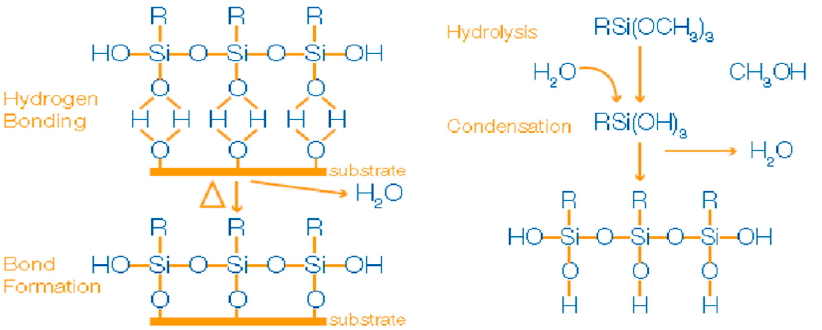
Figure 2. Reaction of an alkyl alkoxy silane with water (hydrolysis) to produce silanol and methanol followed by condensation and bonding to the pores of the concrete substrate .